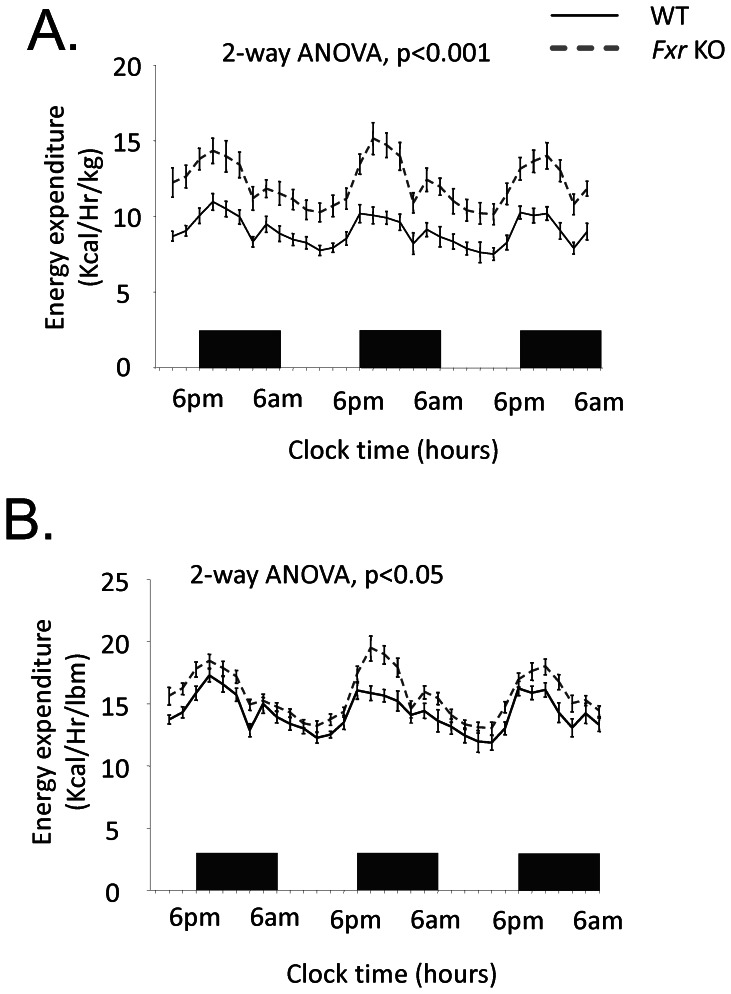
Indirect calorimetry assessment.(A) Energy expenditure relative to body weight assessed in kilocalories per hour and kilogram body weight (kcal/Hr/kg) and (B) energy expenditure relative to lean body mass (lbm) in WT (n = 8, black solid line) and Fxr KO mice (n = 8, grey dashed line). Black bars at the X-axis represent light off. Statistical analysis was performed using a 2 way ANOVA mixed model.